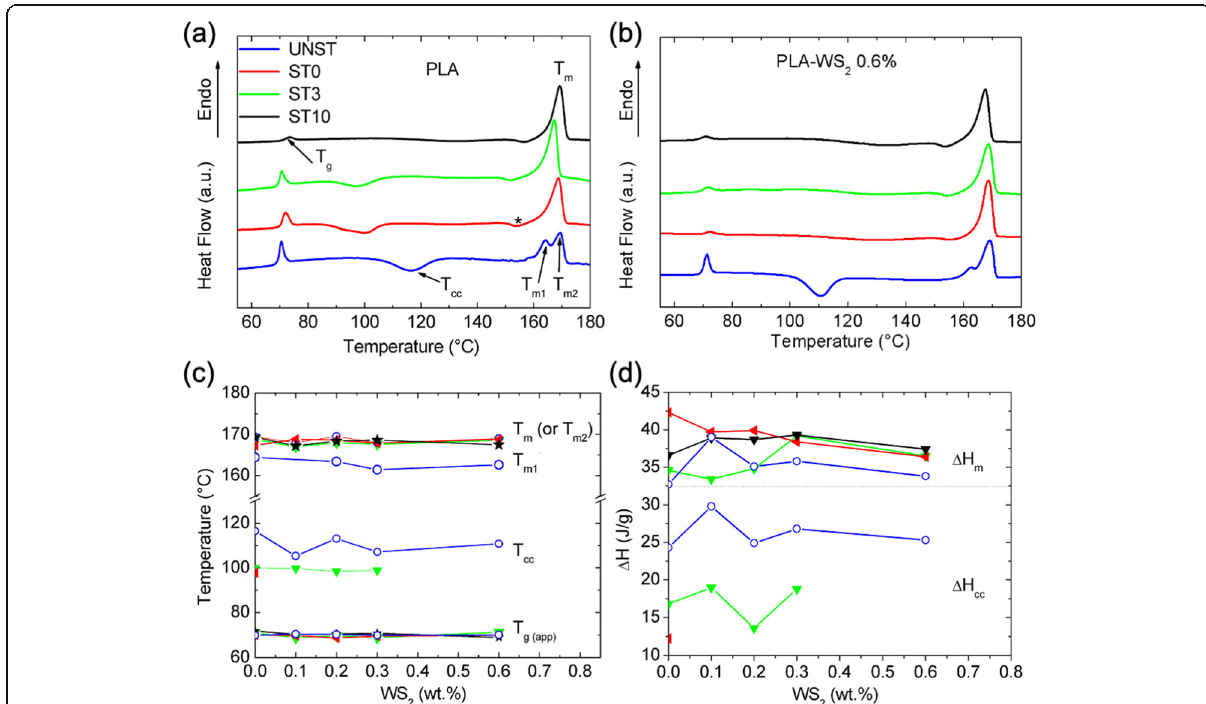
Fig. 8 Results of DSC analysis carried out by heating at 5 °C/min rate UNST, ST0, ST3, ST10 films of neat PLA ( a ) and PLA- WS 2 0.6% films ( b ); temperatures ( c ) and enthalpies ( d ) measured for the relevant phase transitions observed in the DSC thermograms of the